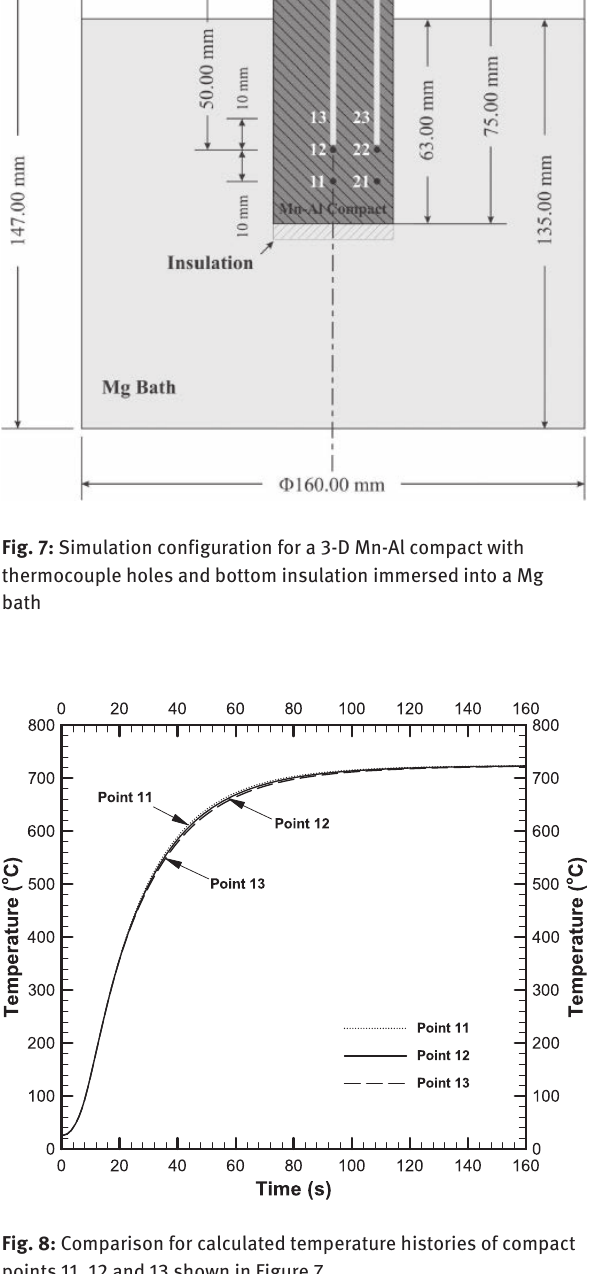
Fig. 8: Comparison for calculated temperature histories of compact points 11, 12 and 13 shown in Figure 7